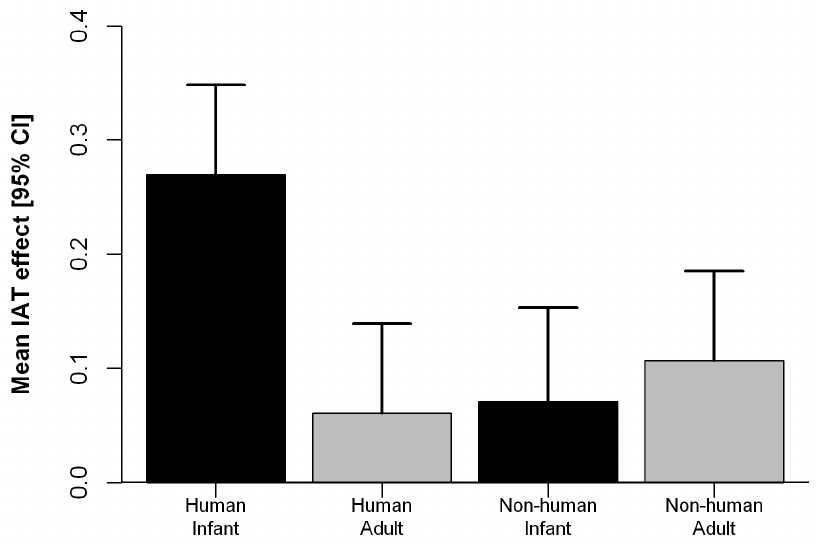
Figure 1. Mean IAT effect as a function of faces. Note. Error bars represent 95% CI.